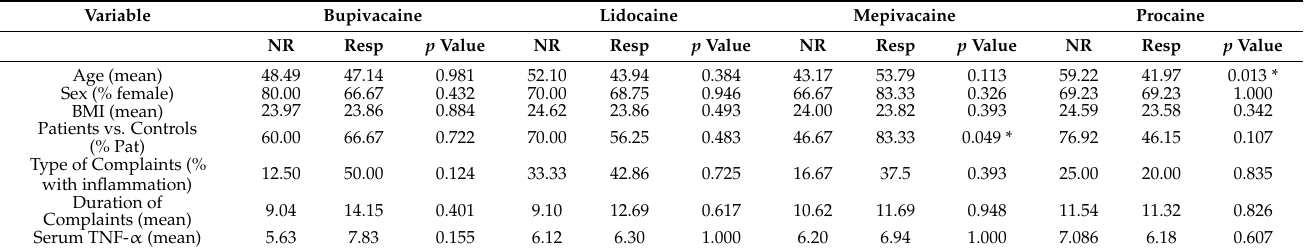
Table 4. Covariates of TNF- α inhibition. Possible influence factors are marked with an asterisk